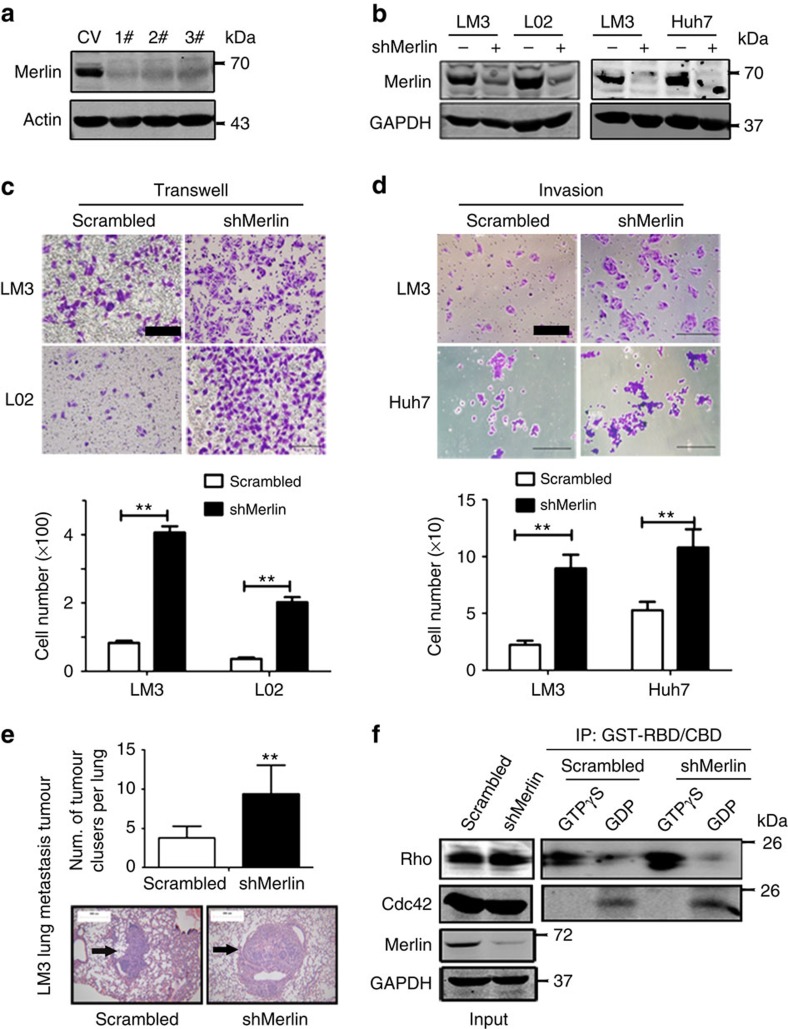
Interfering with the expression of Merlin promotes metastasis in HCC cell lines.(a) Lysates of HCCLM3 cells transfected with Merlin shRNAs were immunoblotted with the indicated antibodies. (b) Generation of shMerlin stable HCCLM3, Huh7 and L02 cell lines. (c) Transwell and (d) invasion assays were used to test the migration and invasion abilities of HCC cells. The respective infiltrated cell numbers are shown in the lower panes. (Scale bar, 50 μM). Results are shown as the mean±s.d., n=3. **P<0.01, ***P<0.001, based on the student's t-test. (e) Representative lung tissue sections of BALB/C mice killed at 13 weeks from each group are shown (H&E; Magnification : × 100, Scale bar, 300 μM ). The arrows indicate lung metastatic tumours (lower images). The average number of lung metastatic tumours per lung in each group (n=5) was calculated (upper panel). Results are shown as the mean±s.d., n=5. **P<0.01, based on the student's t-test. (f) Huh7 cells were treated in vitro with GTPγS or GDP to activate Rho and Cdc42. Cell lysates (50 μl at 1 mg ml−1) in Western blotting showed active Rho and Cdc42 levels in the shMerlin cell line and the control.